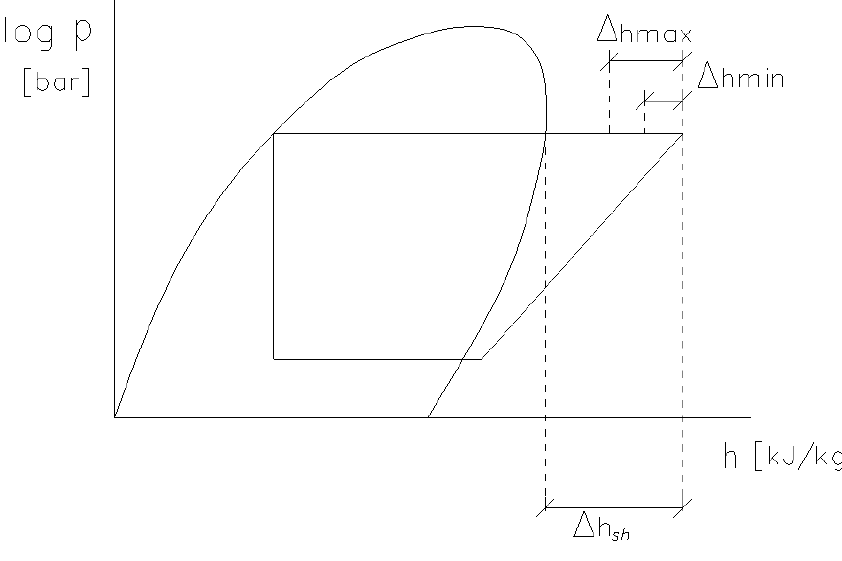
Figure 10. Available enthalpy change Δ h min – Δ h max in